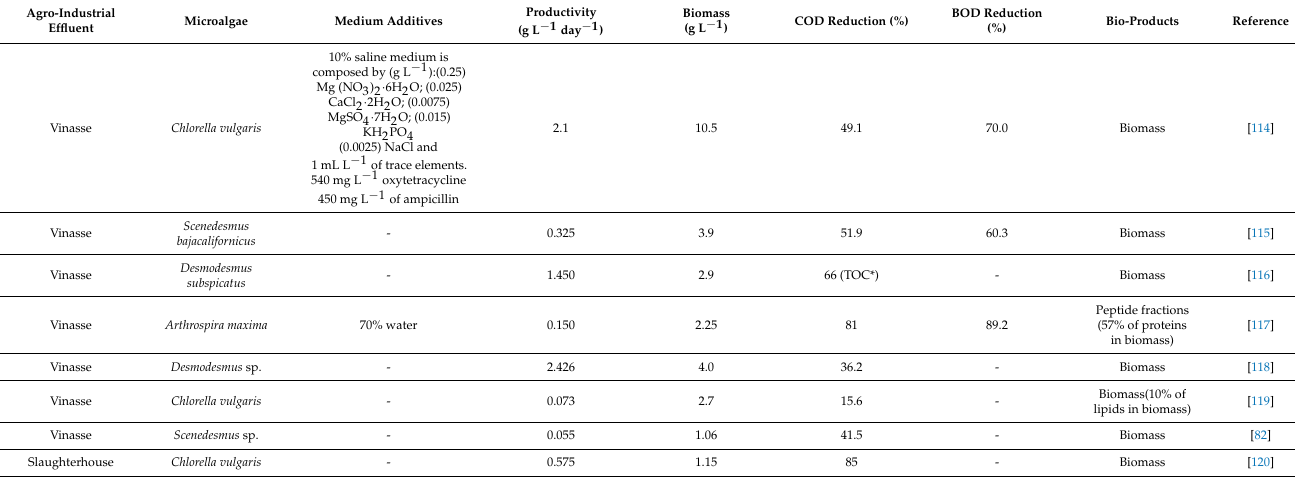
Table 2. Microalgae growth in agro-industrial